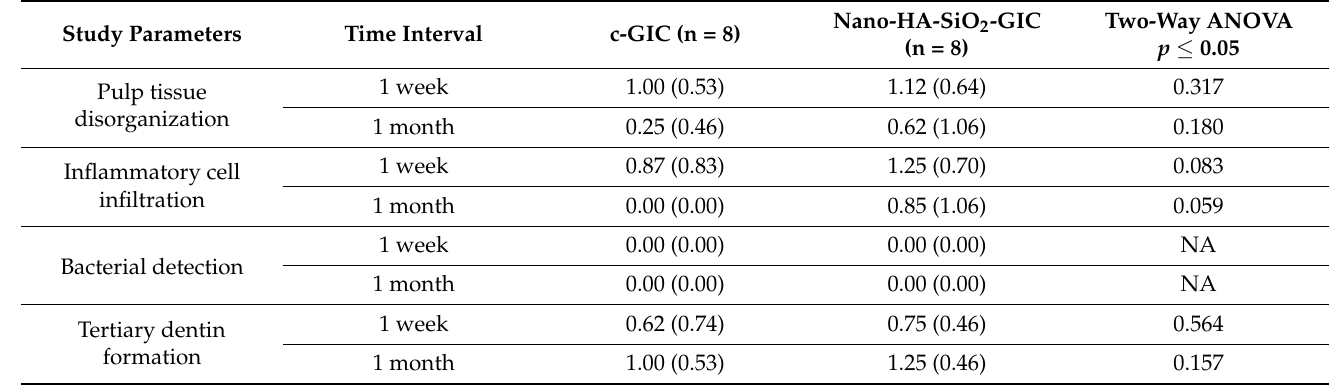
Table 2. Mean score and SD of dentin–pulp complex reaction for occlusal c-GIC and nano-HA-SiO 2 - GIC at each experimental time interval.